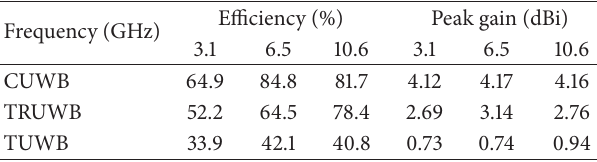
Table 3: Efficiency and peak gain of the proposed